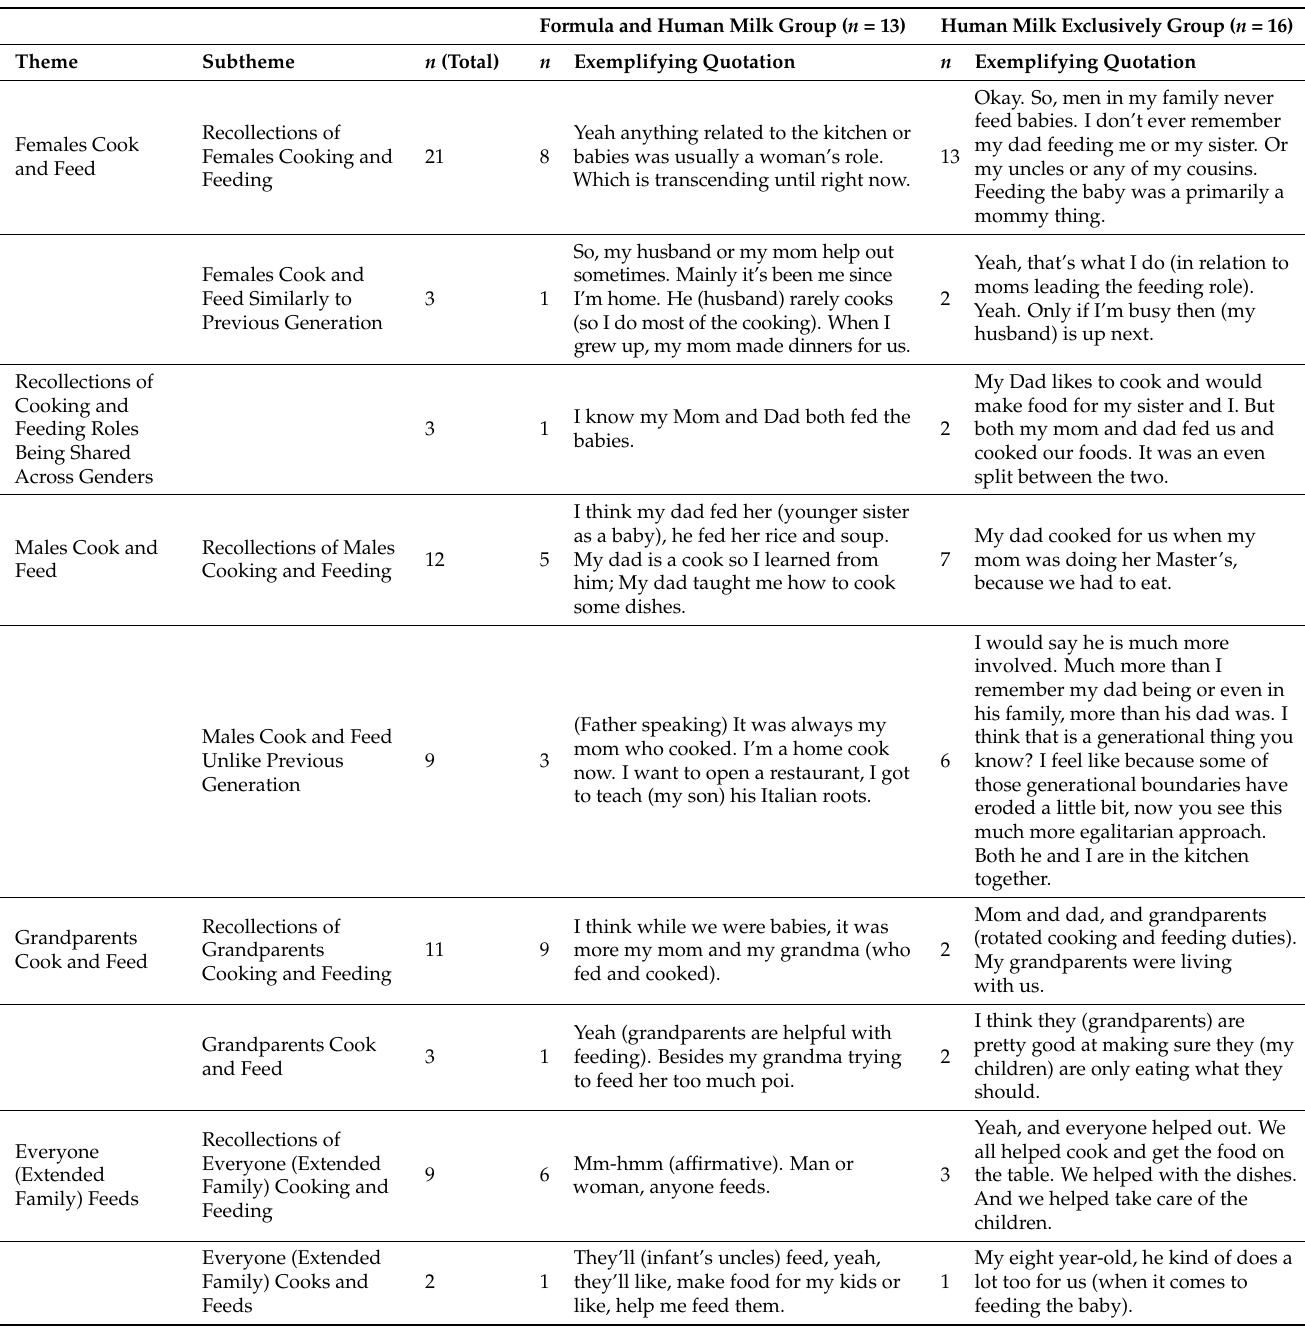
Table 5. Themes and subthemes relating to Transgenerational and Contemporary Complementary Feeding Practices: Roles in Cooking and Feeding Complementary Foods, with exemplifying quotes taken verbatim from in-depth interviews with Native Hawaiian and Other Pacific Islander, and Filipino caregivers, n =